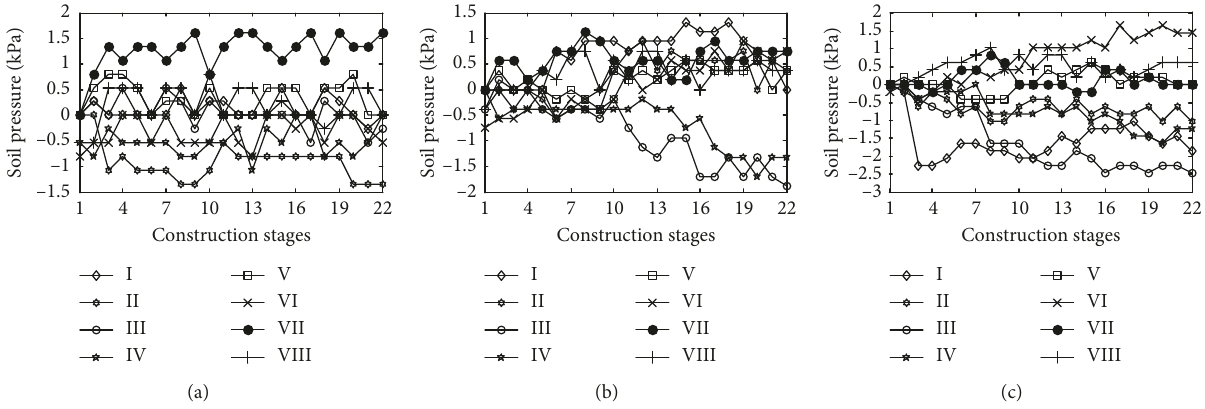
Figure 19: Comparison of soil pressure below the left building foundation. (a) 101. (b) 102. (c) 106.